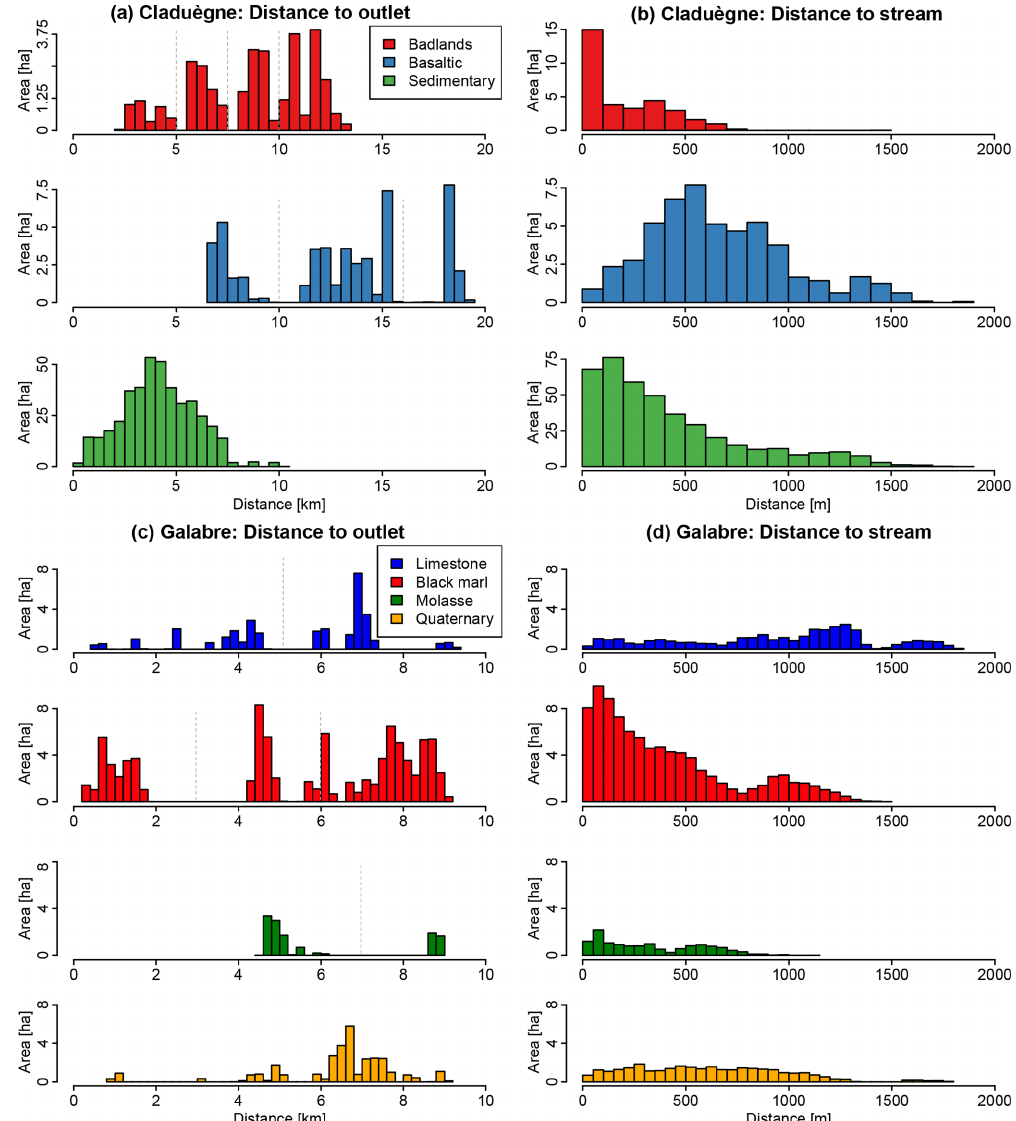
Figure 2. Distribution of the distance of the sources to the outlet ( a for the Claduègne, c for the Galabre) and the stream ( b for the Claduègne, d for the Galabre). The stream was defined with a threshold of contributing drainage area of 50ha. The values represent distances along the flowlines that water and sediments travel following the gradient of the relief. Dashed grey lines correspond to the limits of subgroups of geological sources based on their distance to the outlet modeled in Sc. 4b and